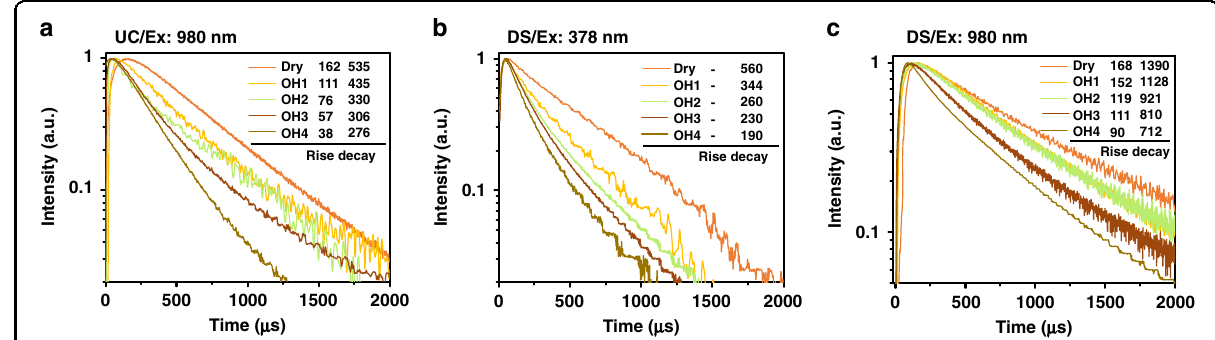
Fig. 3 OH − content dependent UC and DS luminescence dynamical curves. a OH − content dependence of UC green emission dynamics of co- doped core-shell UCNPs (NaYF 4- x (OH) x :Yb,Er@NaYF 4 ) monitored at ~540 nm. b The DS green emission dynamics of core-shell UCNPs (NaYF 4- x (OH) x :Yb, Er@NaYF 4 ) with different OH − contents (excitation: 378nm and emission: 540nm). c The DS NIR emission dynamics of core-shell UCNPs (NaYF 4- x (OH) x : Yb,Er@NaYF 4 ) with different OH − contents (Ex: 980nm and Em: 1530 nm). Numbers marked in Fig. 3 are the rise time and decay lifetimes of the series curves (unit: μ